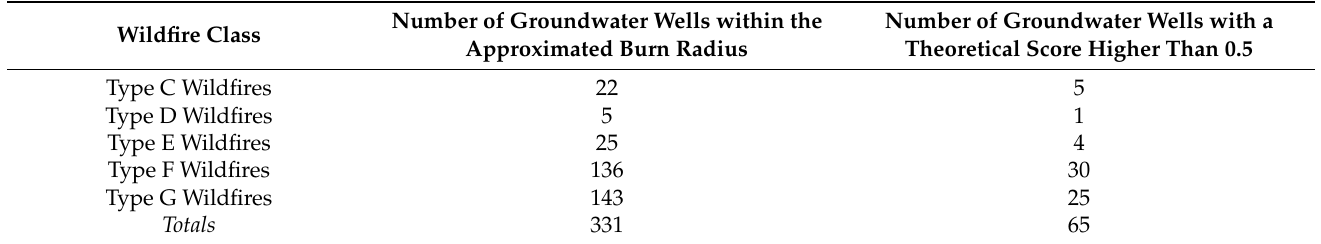
Table 2. The number of results found using PostGIS.